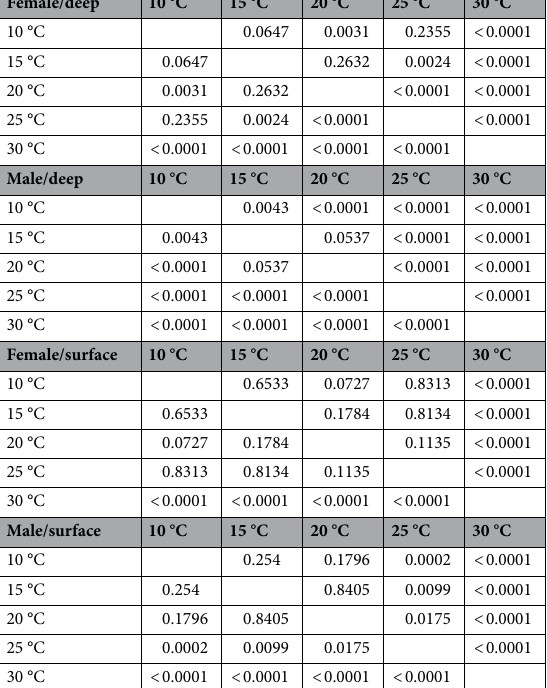
Table 1. p -values of blood flow immediately after cooling at different temperatures.